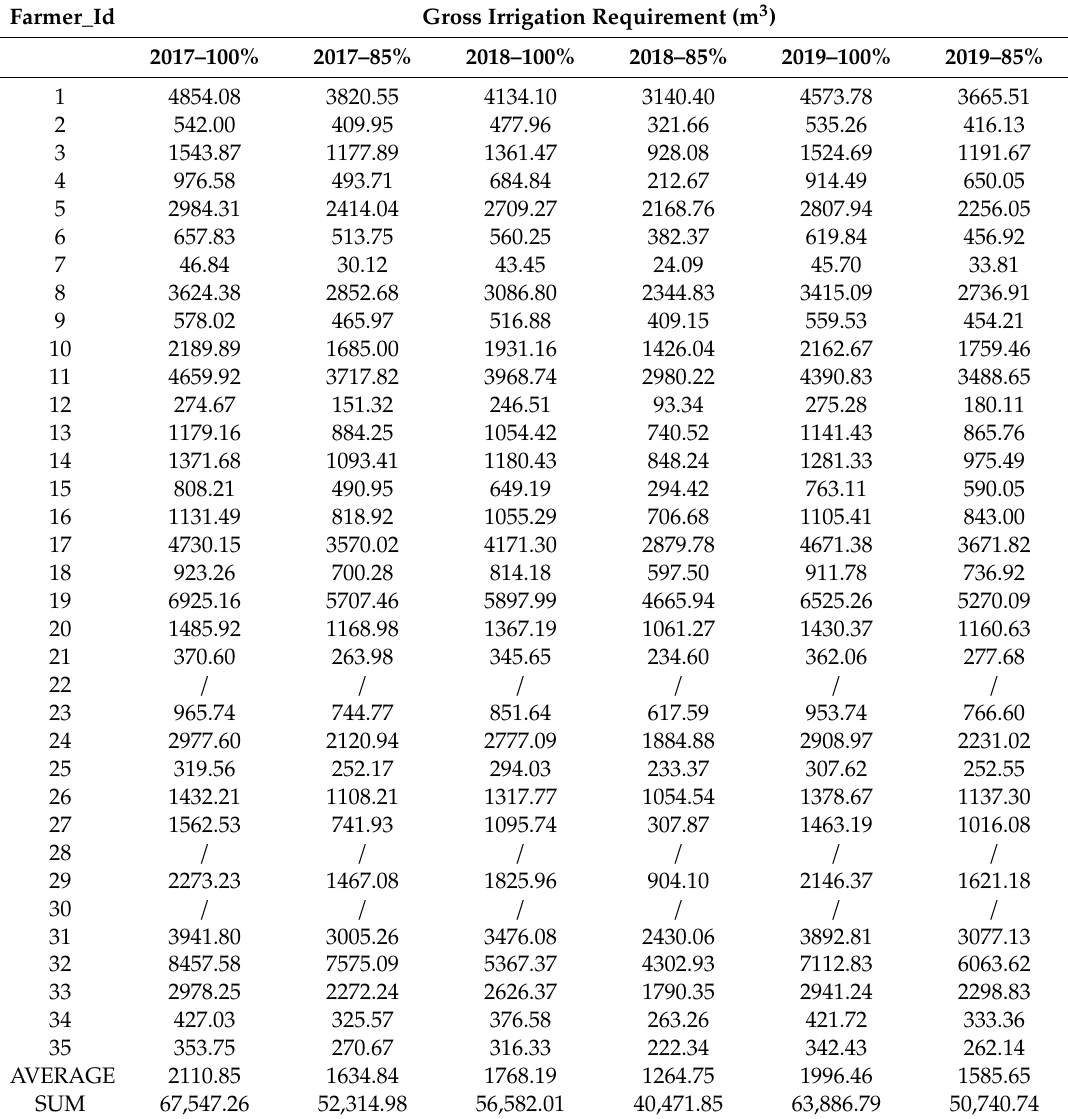
Table A6. Yearly gross irrigation requirement (m 3 ) at farm level by replenishing soil water content to (i) FC and (ii) to 85% capacity